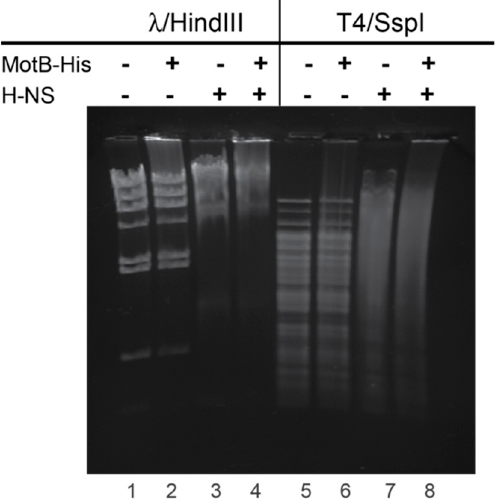
Figure 6. MotB and H-NS bind to both unmodified λ and GHme-C modified T4 DNA. Agarose gel shows the DNA (500 ng) λ or T4 DNA pretreated with HindIII and SspI restriction nucleases (lanes 1 and 5, respectively), after incubation with 60 pmol MotB (lanes 2 and 6), 60 pmol H-NS (lanes 3 and